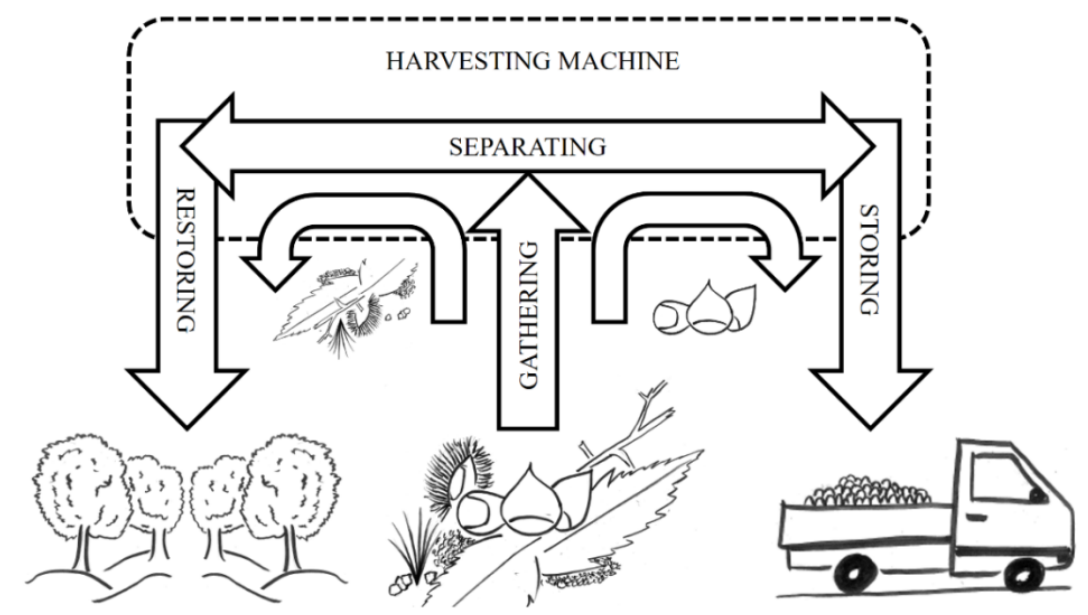
Figure 3. Intermediate steps related to machine functions required to harvest shell fruits from an orchard and collect them in a truck.